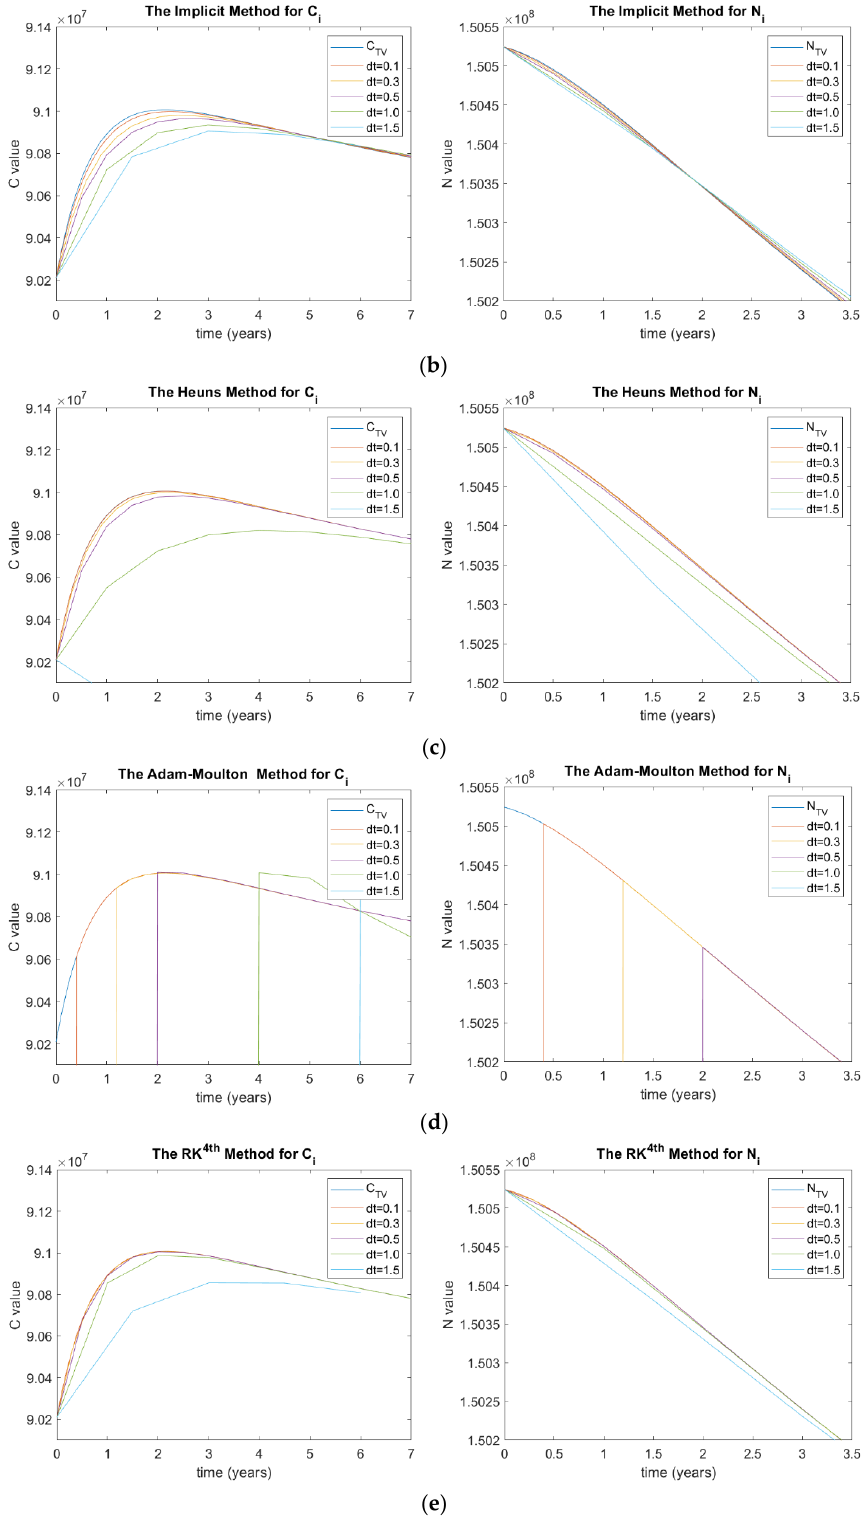
Figure 2. ( a ) Stability analysis of C i and N i in terms of ∆ t for implicit Method; ( b ) for explicit method; ( c ) Heun’s method; ( d ) RK method; ( e ) Adam’s method, where C is the number of diabetic patients with complications and C TV is its true value, N is the total number of people with diabetes and N TV is its true value, and d t is the time step